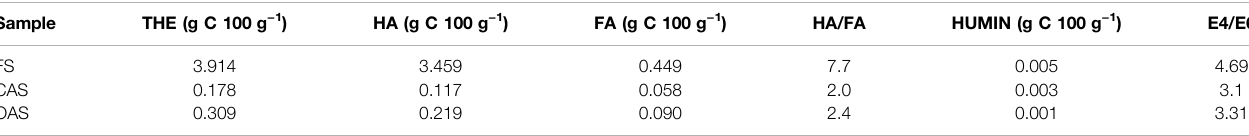
TABLE 5 | Fractionation of the organic matter of samples. Sample